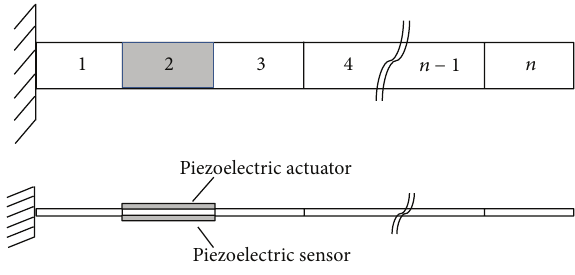
Figure 2: Finite element